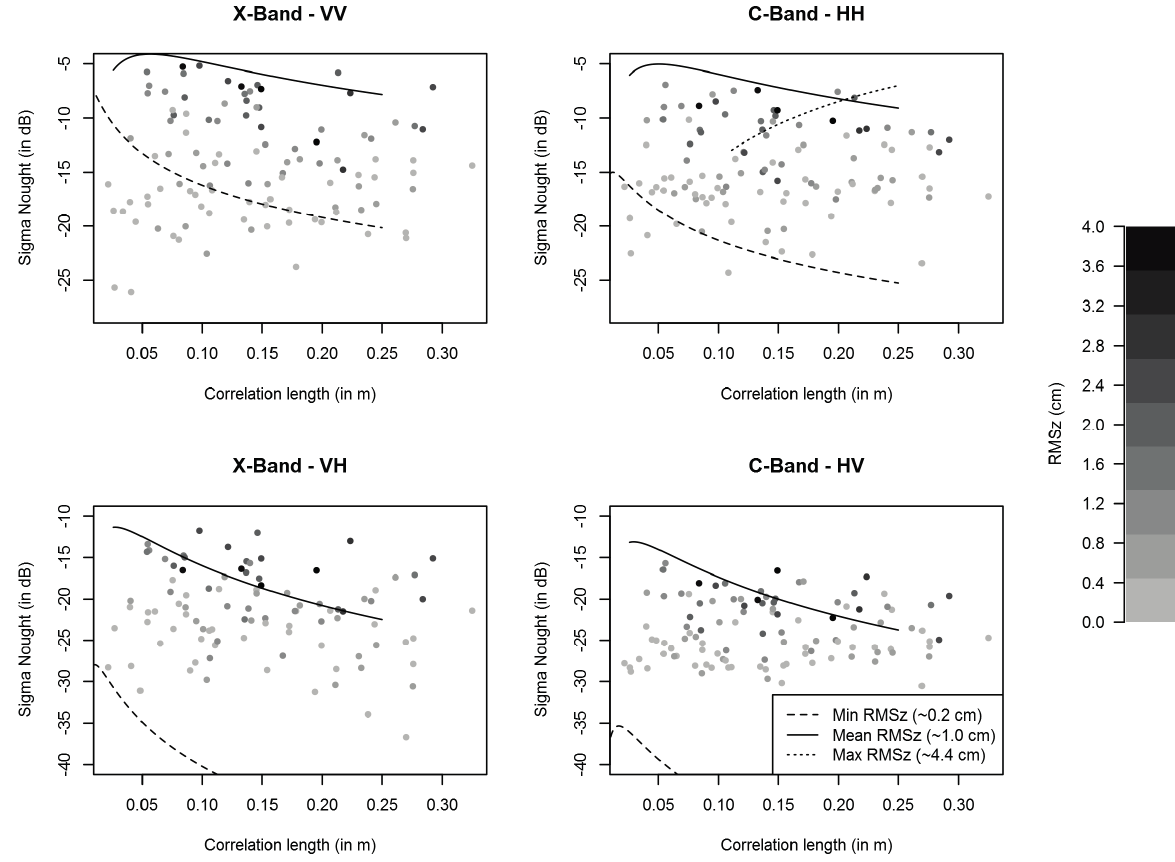
Figure 8. IEM simulations of backscatter (sigma nought) in the X-band (VV and VH polarizations) and C-band (HH and HV polarizations) show the effect of L. For the IEM simulations, minimum, mean and maximum RMSz values were used. An incidence angle of 40° and 34° was assumed for TerraSAR-X and Radarsat-2, respectively. The dots in the graphs are actual observations of surface roughness in the field and their backscatter observed in radar imagery. The grey scale in the images gives an impression of RMSz at the measured sample points. Lines are shown for the validity domain of the